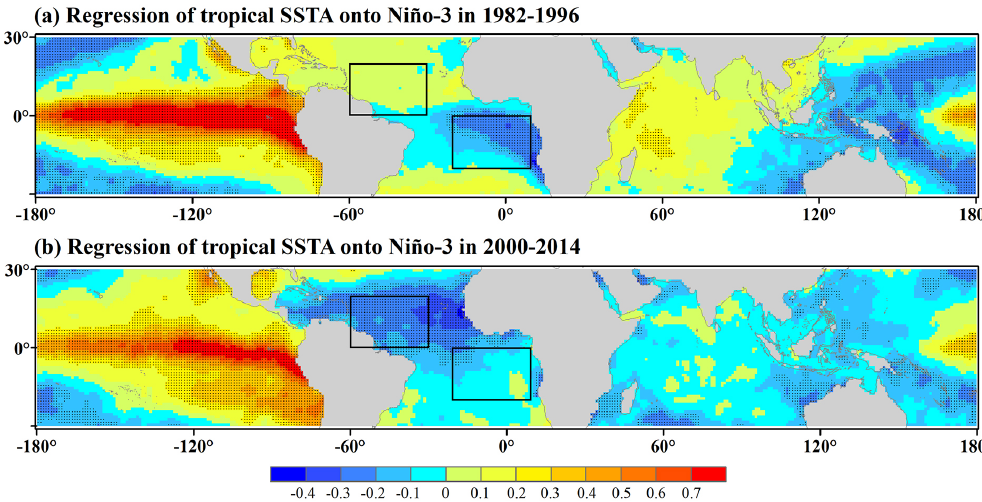
Figure 3. Regression of spring (March–May) tropical SSTA onto the Niño-3 index. Black rectangles denote the regions to define ASGI. The range of the upper one is 60–30 ◦ W, 0–20 ◦ N, and that of the lower one is 20 ◦ W–10 ◦ E, 20–0 ◦ S. The black dots represent significance at the ≥ 90% confidence level, similar to Fig. 2c–d of Yang and Huang (2021) but with different time spans.